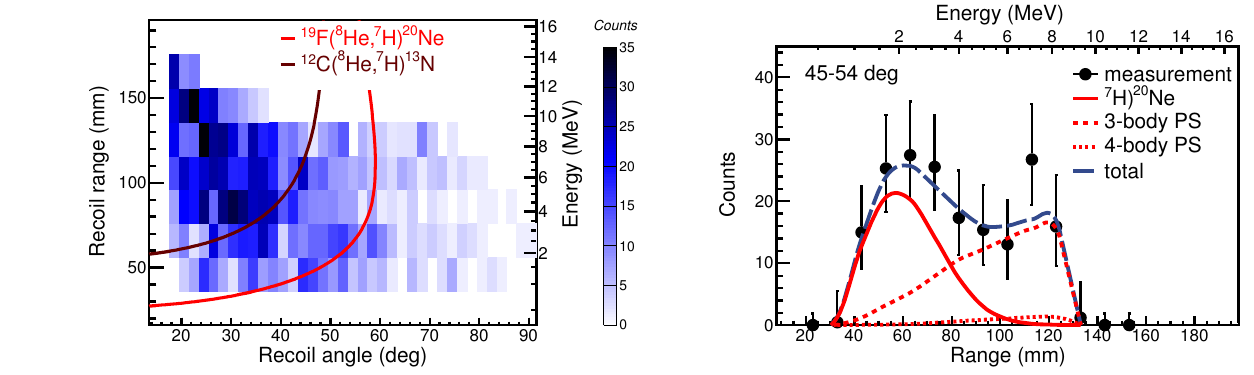
Figure 3. The color scale shows the measured events of the target–like recoil in coincidence with the detection of a 3 H as a beam–like scattered product on the dE–E tele- scope. Solid red / dark red lines correspond to the kinematics of 19 F( 8 He, 7 H) 20 Ne and 12 C( 8 He, 7 H) 13 N, respectively.